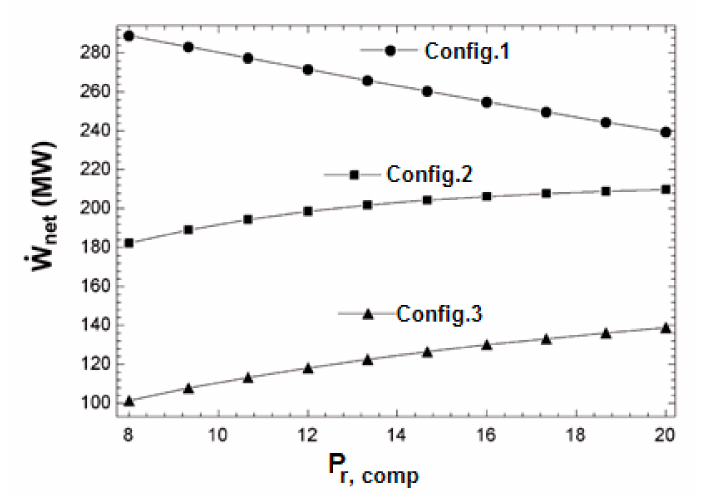
Figure 4. Effect of compressor pressure ratio change on the overall output power.